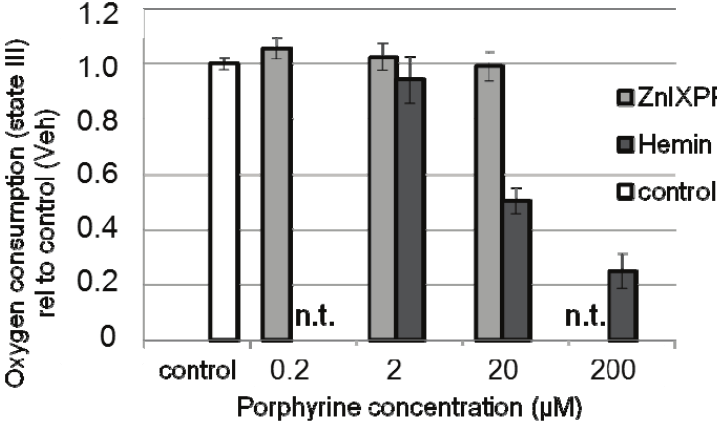
Figure 4. Hemin compromizes respiration of mitochondria. Isolated mitochondria were supplemented with succinate/rotenon to promote respiration of complex II. Transition to state III was induced by adding ADP and oxygen consumption was determined immediately after adding vehicle, hemin in the following concentrations: 2, 20 and 200 μM. In order to exclude effects of the HO inhibitor we also tested ZnIXPP (HO inhibitor) in the following concentrations: 0.2, 2 and 20 μM. Concentrations not tested are indicated (n.t.). State III respiration is indicated relative to the control (vehicle alone, set to 1). Data are given as means (±SD) obtained from one experiment with n = 5